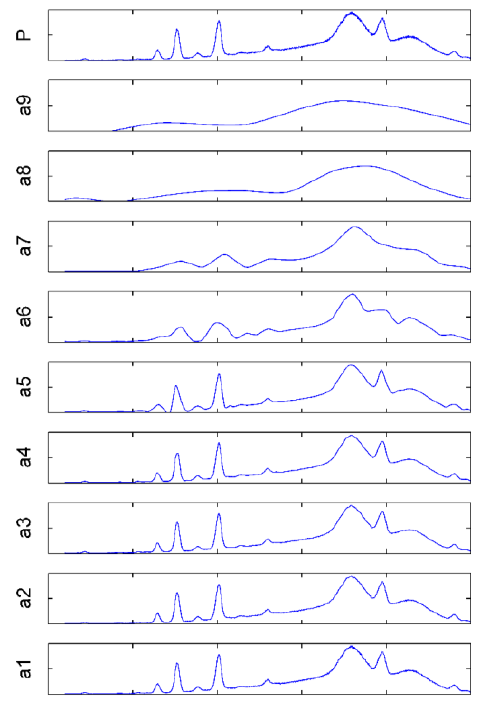
Figure 4. Approximate background of XRF obtained by DWT with the coif 3 at level 9. P indicates the raw spectrum, a1–a9 are results on the decomposition levels 1–9.